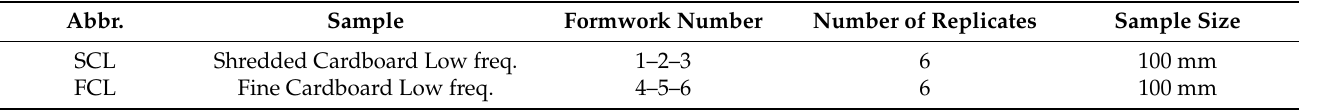
Table 2. Samples Tested for Low-Frequency Sound